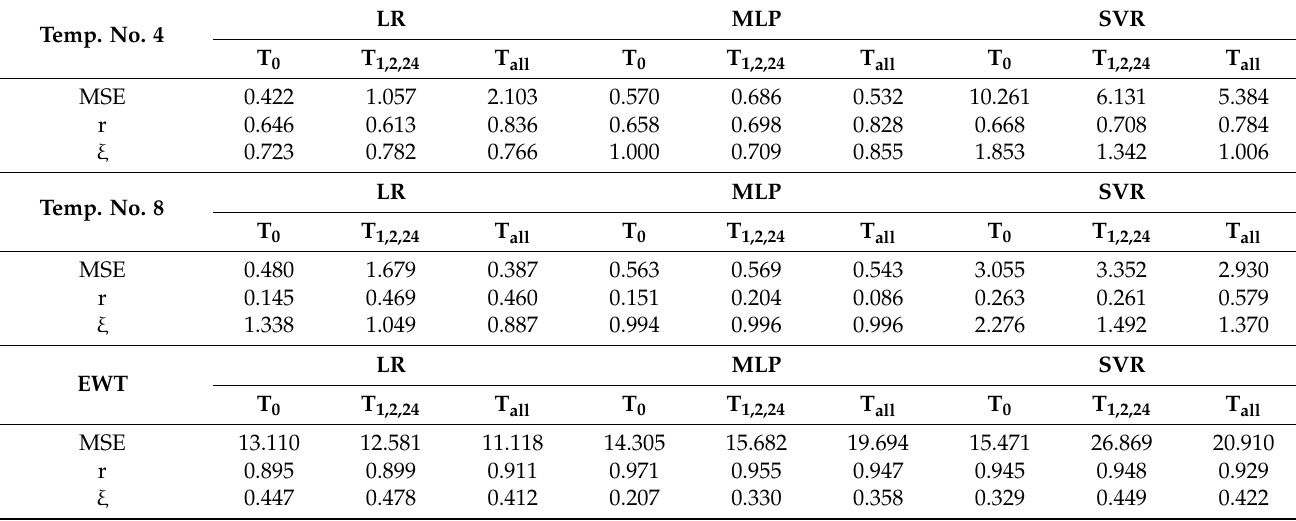
Table 4. Prediction results for LR, MLP, and SVR models in HVAC